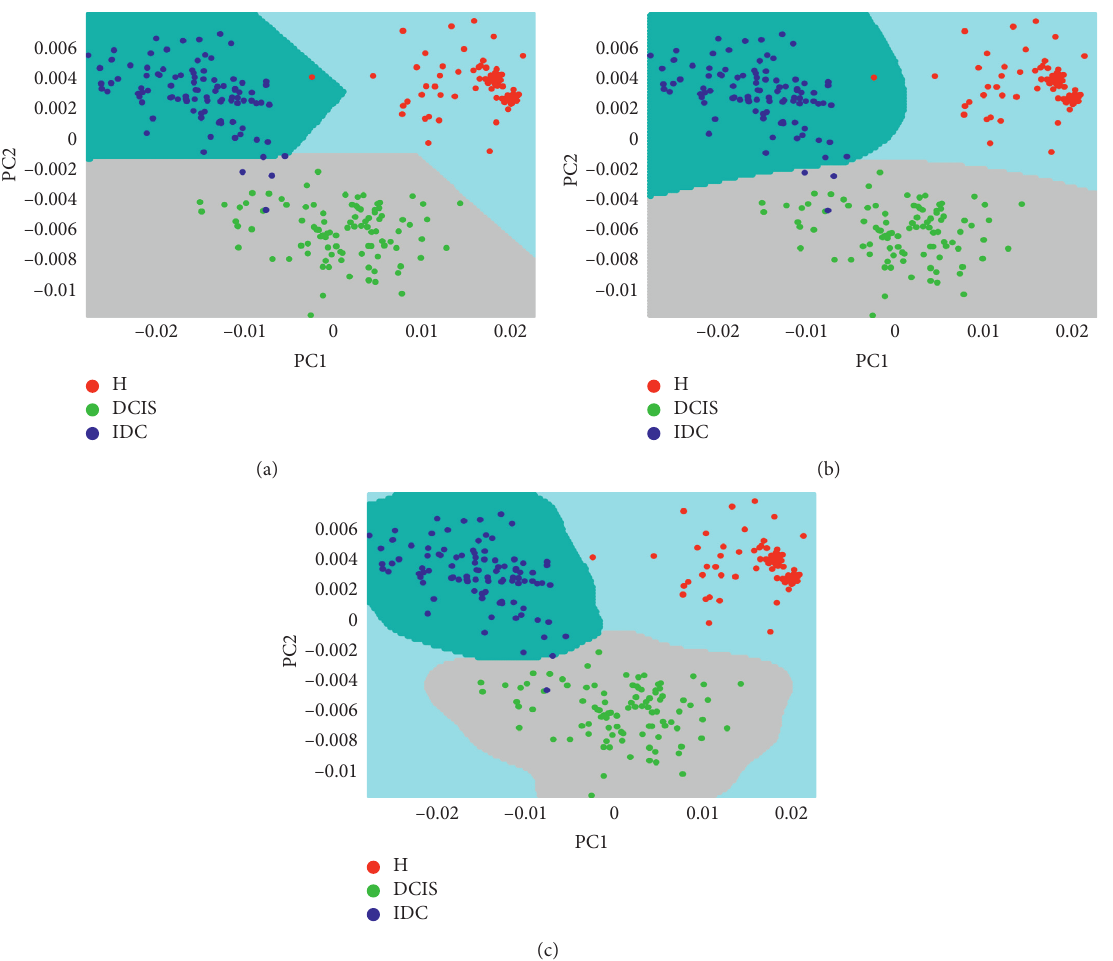
Figure 8: Scattering plots of PCA-SVM algorithm based on three kernel functions. (a) PCA-SVM with linear kernel, (b) PCA-SVM with polynomial kernel, and (c) PCA-SVM with RBF kernel. Points in different colors represent different tissue types; background color represents class domain created by SVM (a, linear kernel; b, polynomial kernel; c, RBF